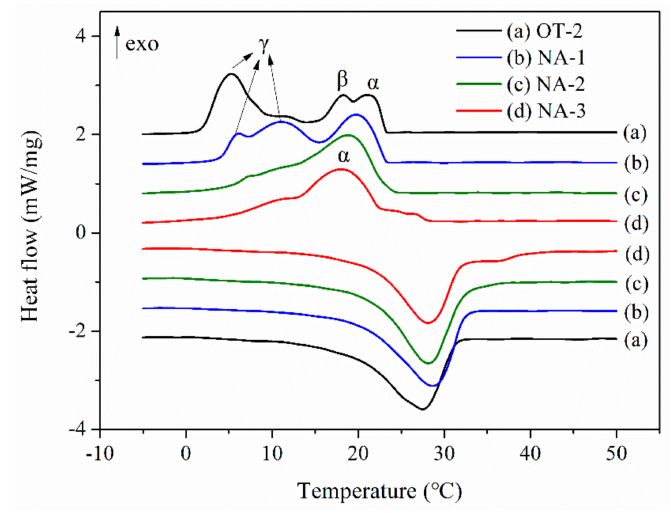
Figure 8. DSC curves of composite microcapsules with